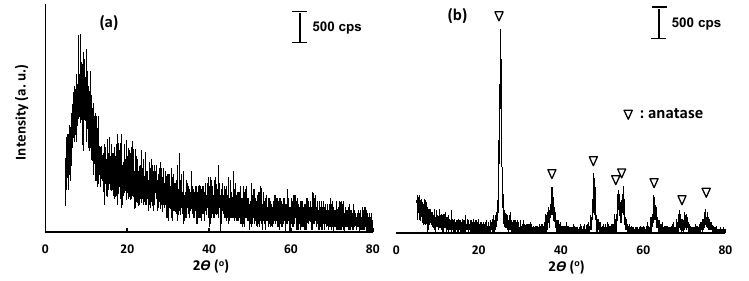
◦ C ( a ) and 500 ◦ C ( b ).